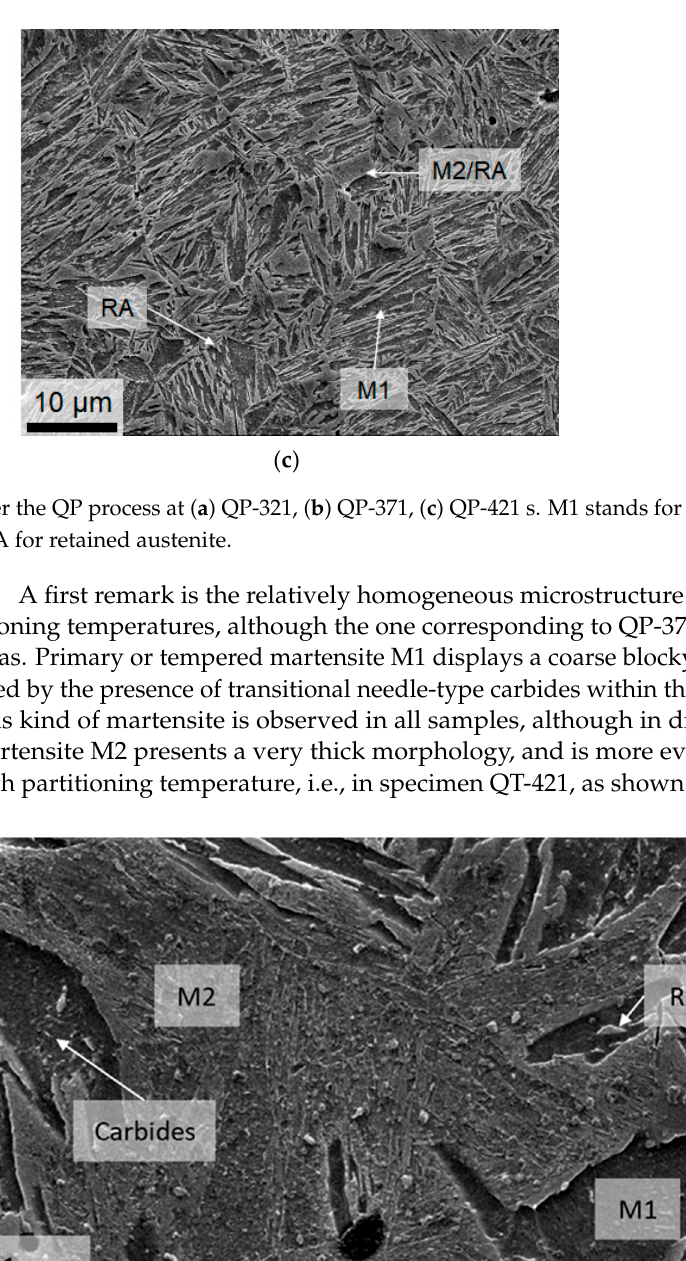
Figure 8. SEM micrograph of sample QP-421. M1 stands for tempered martensite, M2 for fresh martensite, RA for retained austenite and carbides of M1.